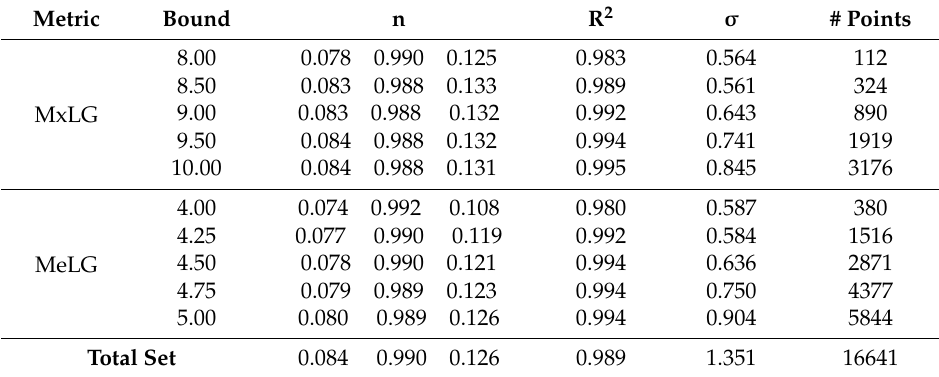
Table 4. Best fit line statistics for LG methods, bounds in ◦ C/m.